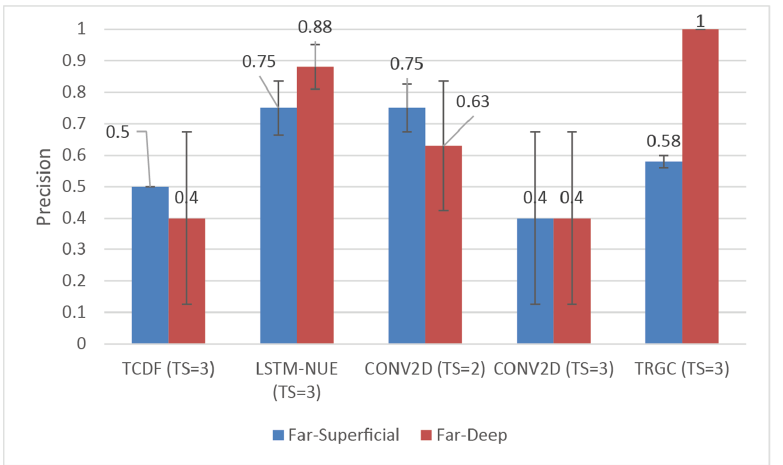
Figure 8. Mean Precision for all methods (L = 1500). Sensitivity Ranking Far–Superficial: TRGC > Conv2D (TS = 2) > LSTM-NUE > TCDF > Conv2D (TS = 3). Sensitivity Ranking Far–Deep: TRGC > LSTM-NUE > Conv2D (TS = 2) > Conv2D (TS = 3) = TCDF. Abbreviation TS = amount of time series included in the predictions.